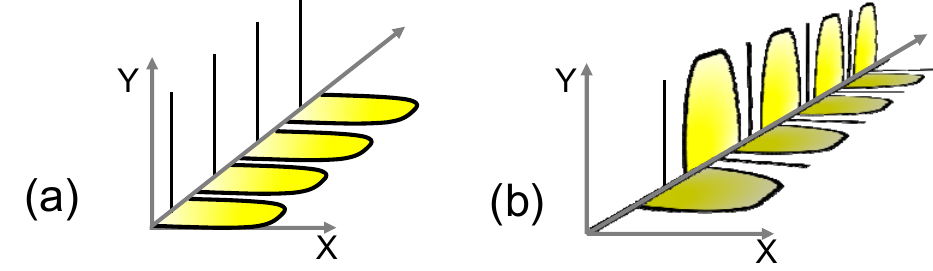
Figure 5. PT and signal relationship for PDM-SHD and PT-interleaved